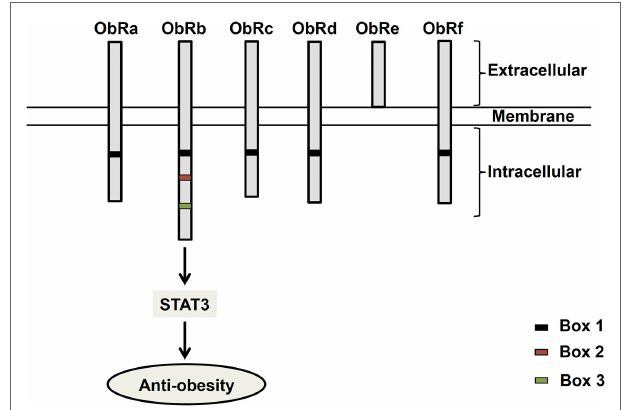
FiGURe 1 | Structure of leptin receptor isoforms . Six different spliced isoforms of the leptin receptors (ObR) have been documented as ObRa–ObRf. All the isoforms share identical extracellular binding domain. ObRb possesses the longest intracellular domain, which is important for leptin